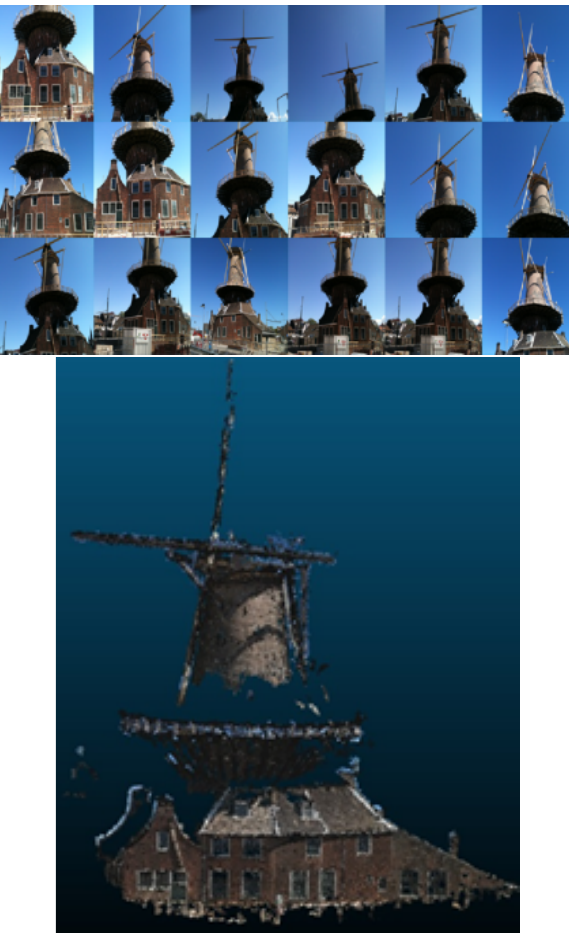
Figure 3: Top; Some samples from multi-view iPhone image data set of the historical windmill. Bottom; Automacatically gener- ated point cloud.